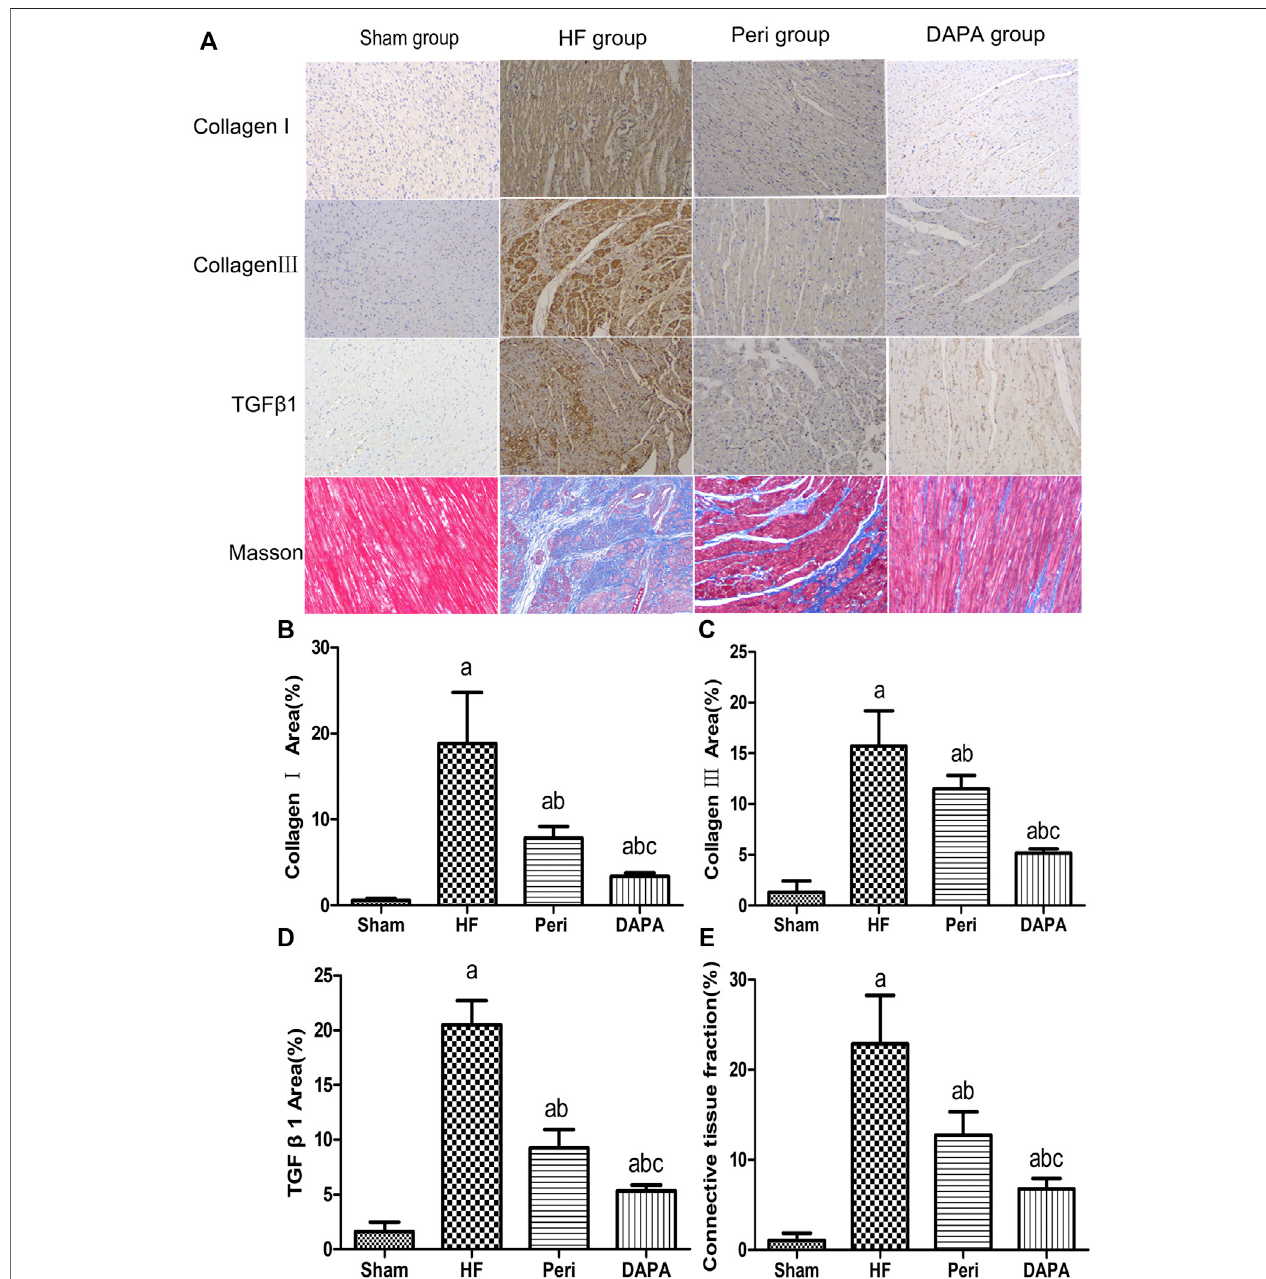
FIGURE 3 | DAPA suppresses myocardial fi brosis in the CHF rabbit model. IHC staining of collagen I, collagen III, and TGF- β 1 and Masson ’ s trichrome staining of the myocardium. (A) Percentages ofpositive areas ofcollagen I (B) , collagen III (C) , TGF- β 1 , and (D) connective tissue fraction. (E) Data were expressed as the mean ± SD. a p < 0.05 vs. the sham group; b p < 0.05 vs. the HF group; c p < 0.05 vs. the Peri group.